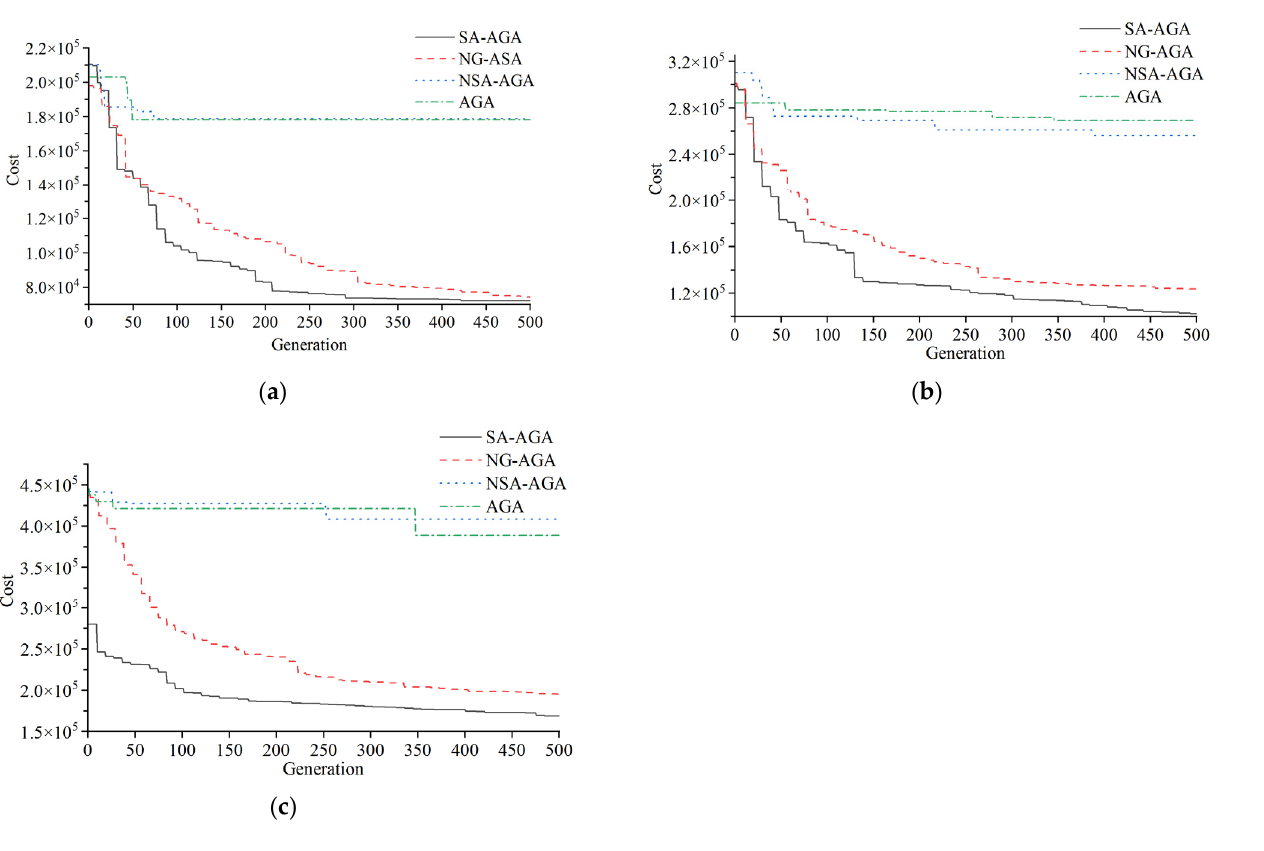
Table 9. The objective value of solutions under S + U and M + U. Scale